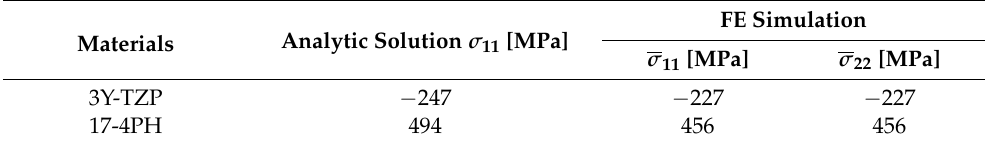
Table 1. Comparison of the stresses in the three-layer MCLs between the analytic solution and FE simulation.